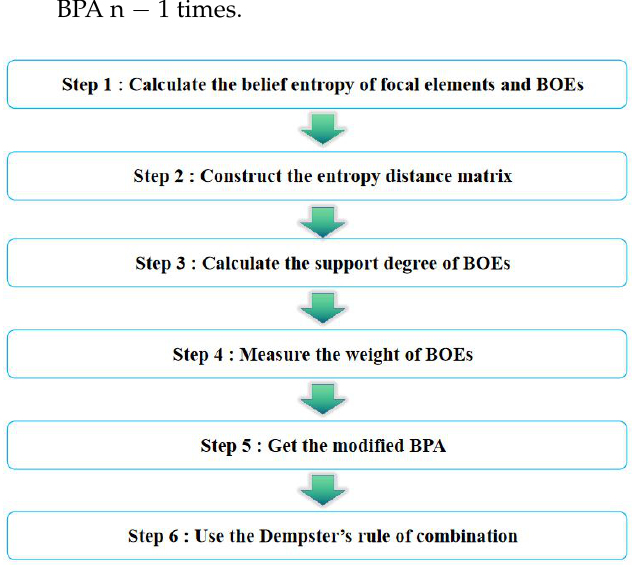
Figure 8. The flow chart of the proposed method.